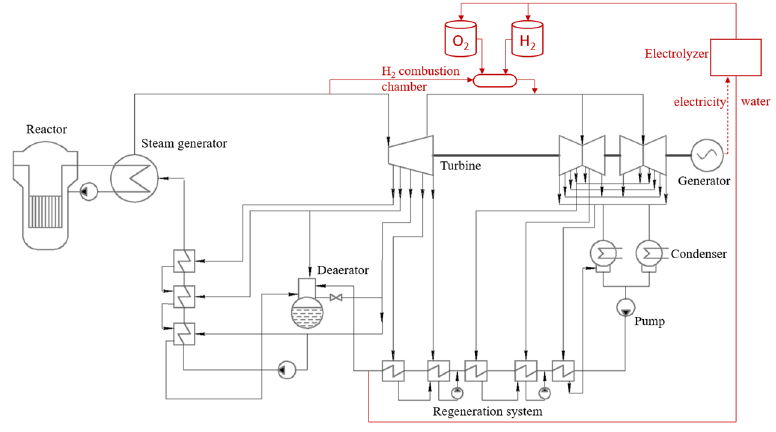
Figure 18. Power plant facility equipped with hydrogen accumulation.